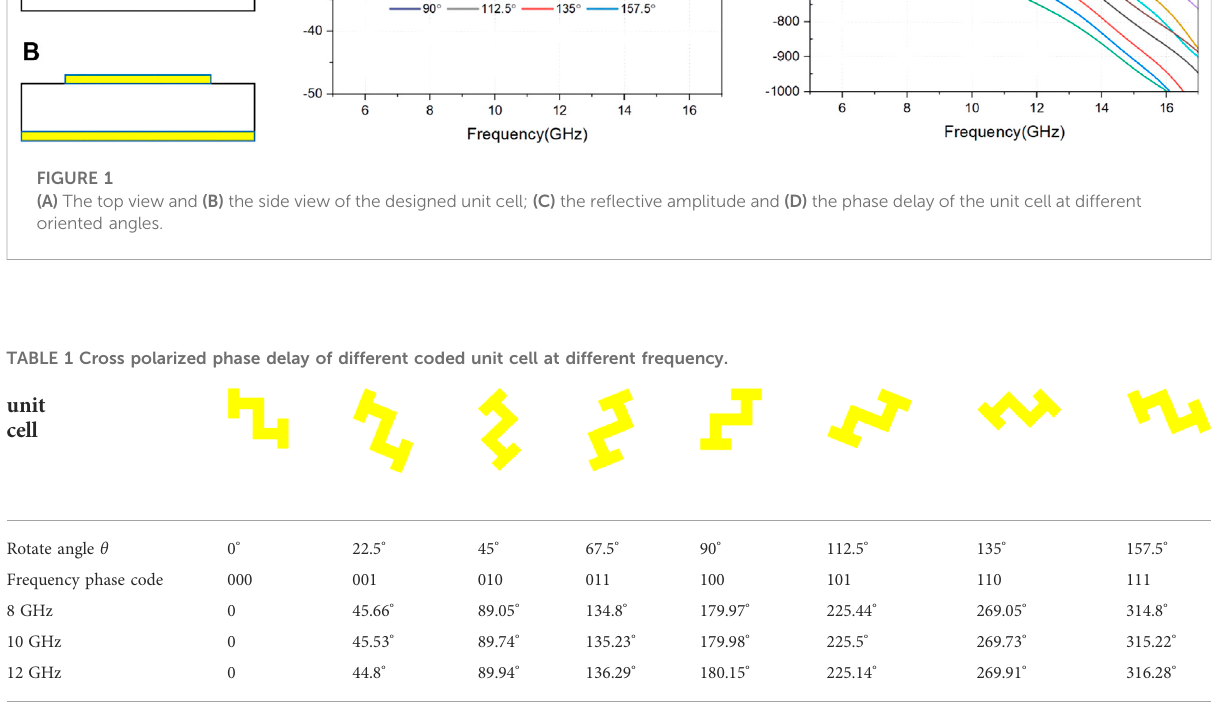
cell. The metasurface is modelled using Microwave Studio of Computer Simulation Technology (CST) in periodic boundary condition. The substrate of the metasurface is made of FR4 with permittivity of 4.3 and thickness of 1.6 mm. The Z-shaped structure and the metal layer at the backside of the substrate are made of copper with conductance of 5.8 × 10 7 S/m. A left circularly polarized plane wave is normally incident on the metasurface and the cross-polarized re fl ective spectrum of the EM wave are numerically analyzed from 4 GHz to 18 GHz range. Figures 1C,D plot the simulated amplitude and the phase delay of the re fl ective spectrum at different unit cell orientation angle θ . As θ changes from 0 ° to 157.5 ° with step size of 22.5 ° , the cross polarized re fl ective amplitude R keeps almost the same at different θ in the investigated frequency range, while the phase delay changes linearly with θ and the change can be up to 360 ° as θ increases by 180 ° . Therefore, it is possible to control the wave front re fl ective EM beam by simply setting the rotated angle of the unit cell at a speci fi c spatial position.